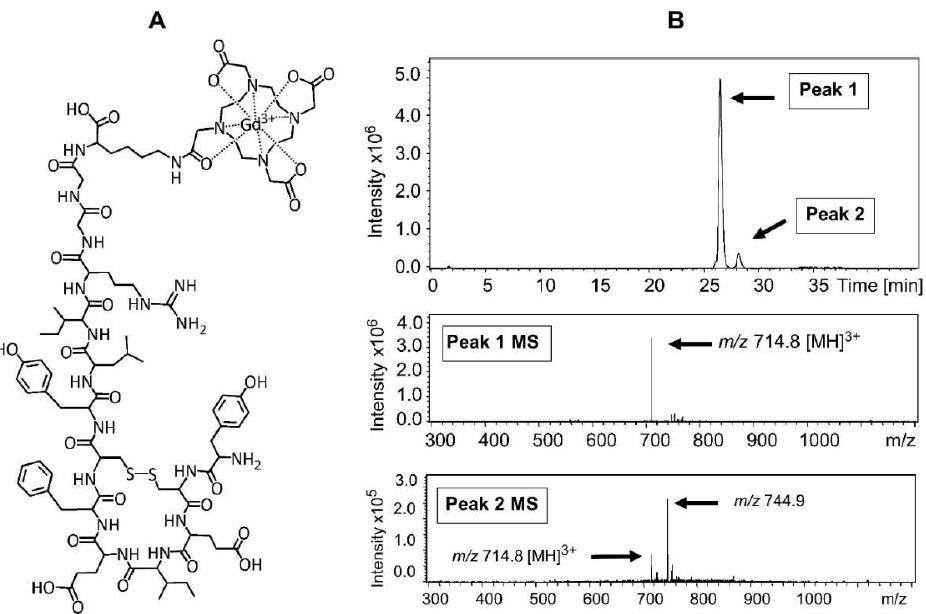
Figure 4. ( A ) Schematic representation of DOTA-OP3-4 with Gd 3+ conjugate (DOTA-Gd-OP3-4); ( B ) Chromatographic separation profile of the purified DOTA-Gd-OP3-4. The ITMS spectra of the ions eluted in peak 1 (putative peptide) and peak 2 (contaminating fraction) are also shown (bottom). The purity of the peptide, estimated by integration of the peak areas, was >90%.